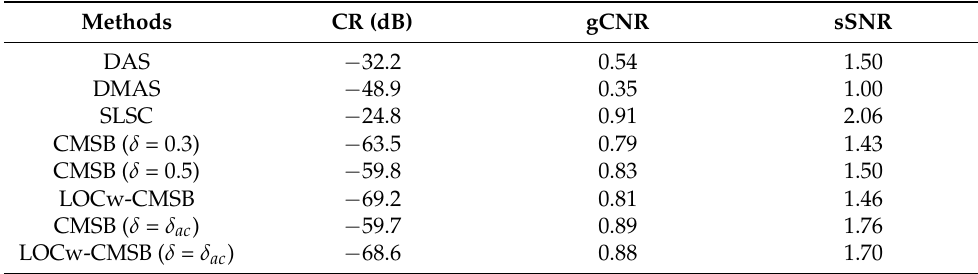
Figure 8. In vivo cross section view of carotid images reconstructed by ( a ) DAS, ( b ) DMAS, ( c ) SLSC, ( d ) CMSB ( δ = 0.7), ( e ) CMSB ( δ = 1.3), ( f ) LOCw-CMSB, ( g ) CMSB ( δ = δ ac ), and ( h ) LOCw-CMSB ( δ = δ ac ). Table 5. Image quality metrics of in vivo carotid images obtained by different